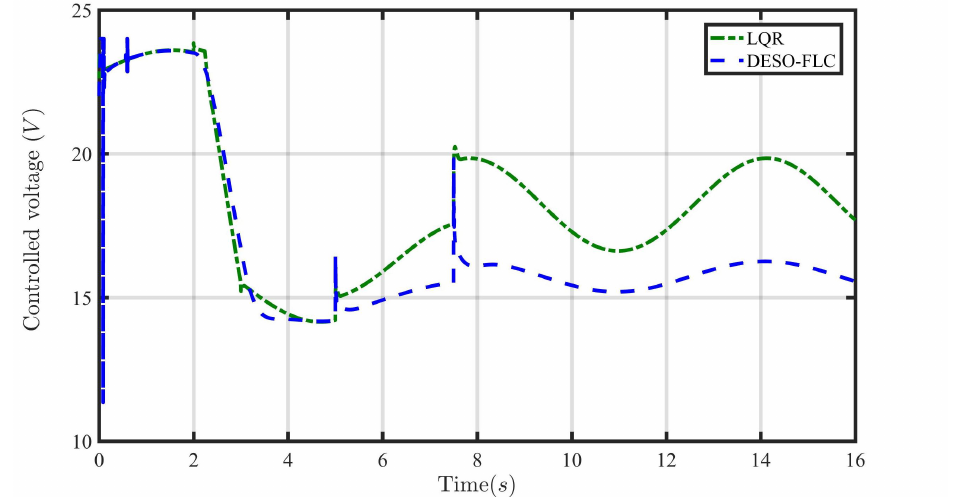
Figure 16. Response of the controlled voltage ( V C ) in the presence of payload disturbances and parametric uncertainties. Table 5. Comparison of ISE and ITAE using various control approaches for case 3. Control